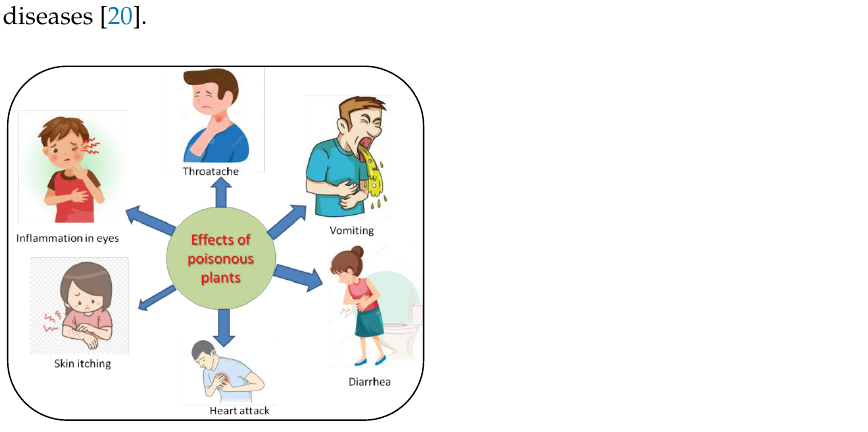
Figure 2. General symptoms of the poisonous plants in humans after touching and ingestion. The toxicity of poisonous plants in some cases resides in whole plant, while in other cases in some parts of the plant, such as the shoot, leaves, flower, seeds, bark or even latex [21]. The continuous research and development in plant knowledge has promoted a marked increase in the awareness and usefulness of plants for medicinal purposes [22], as well as on their toxicological profiles